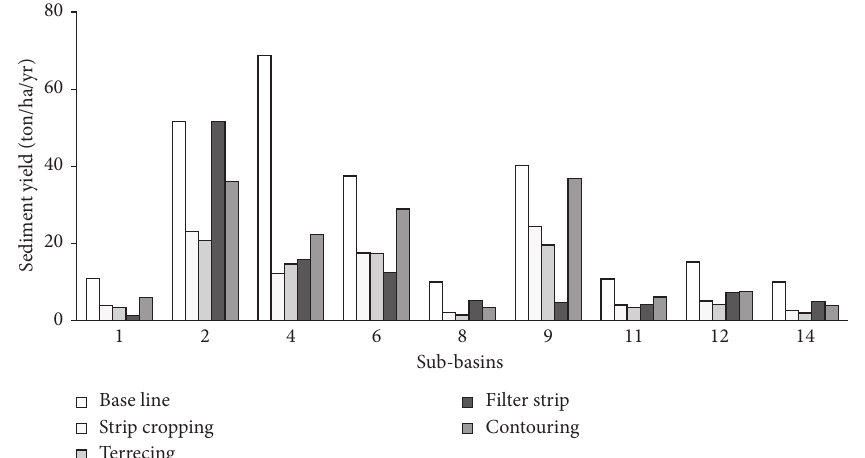
Figure 4: The average sediment yield from highly eroded subbasins without and with